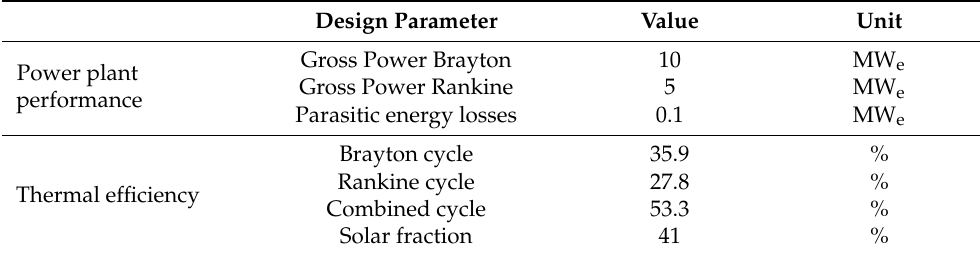
Table 8. EBSILON results of the CRS plant with the RO unit. Design